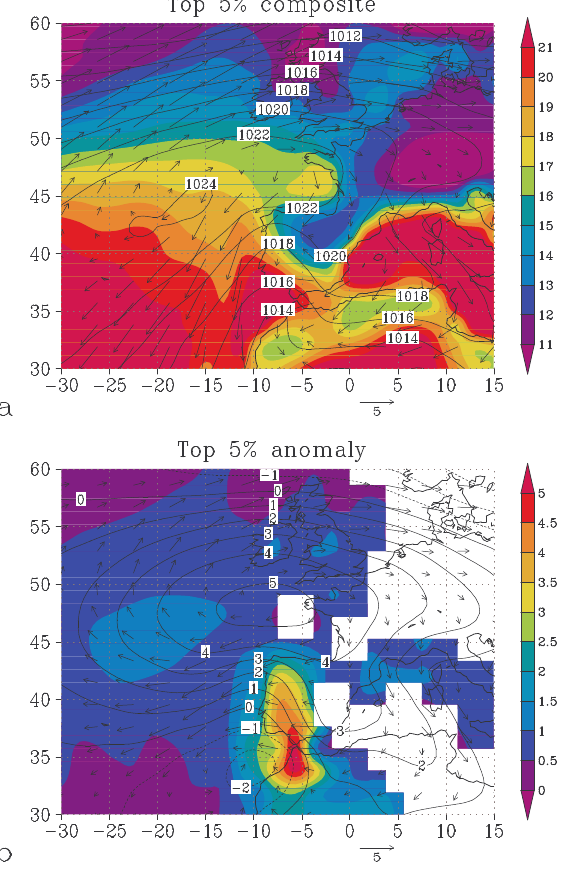
Fig. 7. As Fig. 6 but for T min